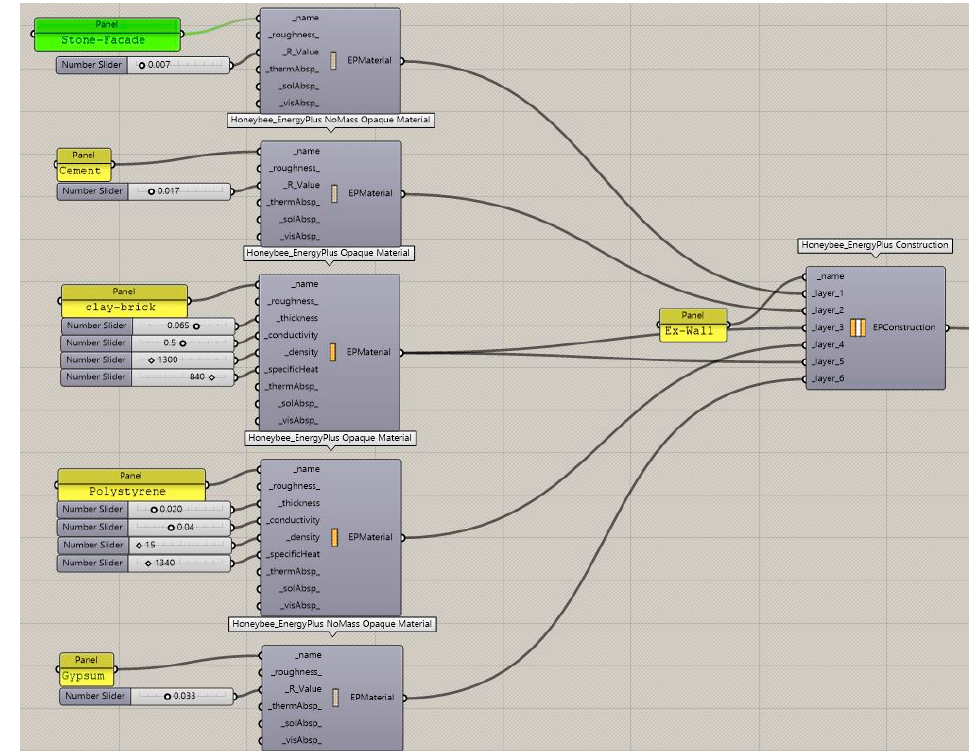
Figure 6. U ‐ value calculations. Figure 6. U-value calculations. The U-value for the outer wall is assumed to be 0.365 W/m 2 K. Double-glazed window glass is transparent and uncoated, with a visible light transmission coefficient of 77%, a U-value of 0.65 W/m 2 K, and a reflectance coefficient of 1.52 (Table 3). Table 3. Window features.